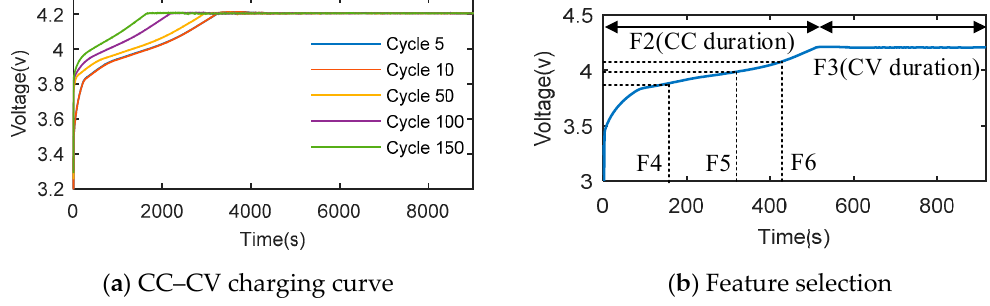
Figure 1. The feature selection in charging curve.